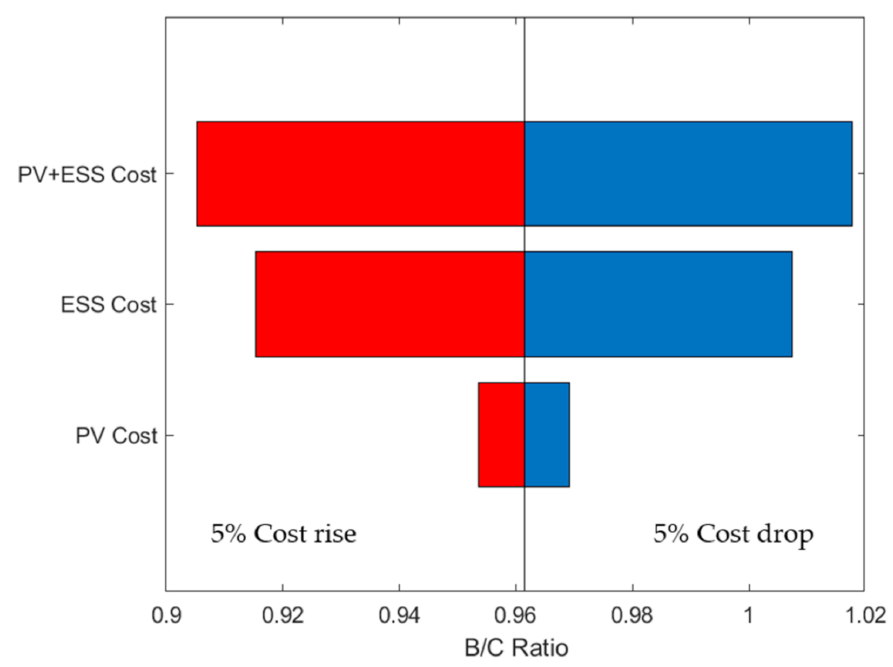
Figure 7. B/C ratio sensitivity owing to the cost